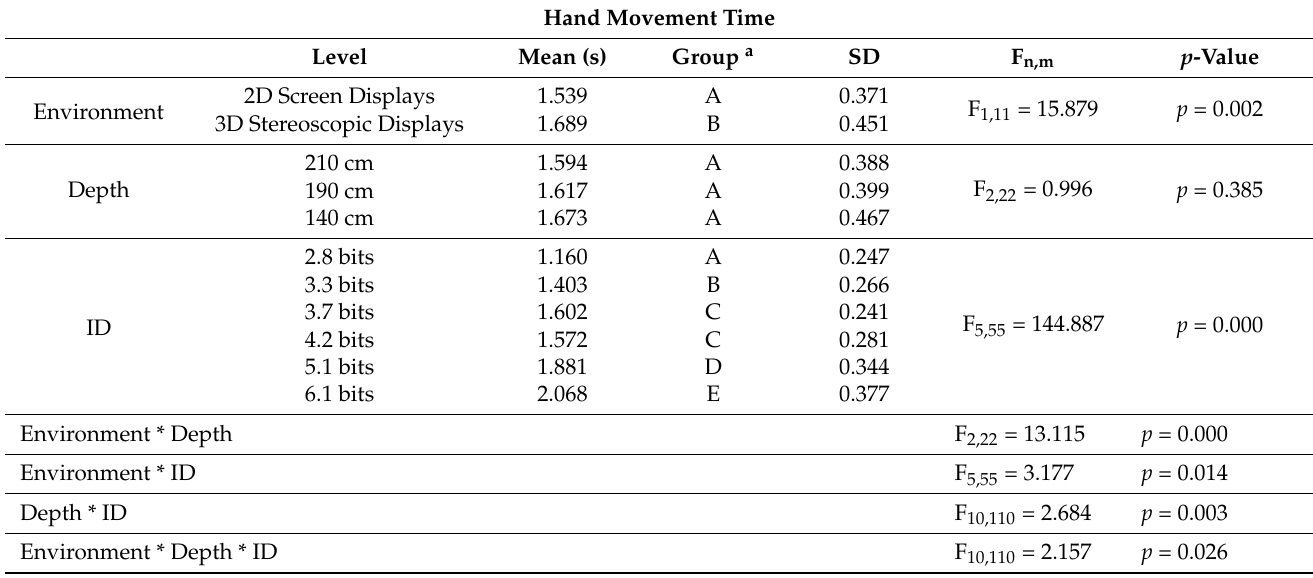
Table 10. Means, SDs, ANOVA, and Tukey HSD test results of hand movement time.